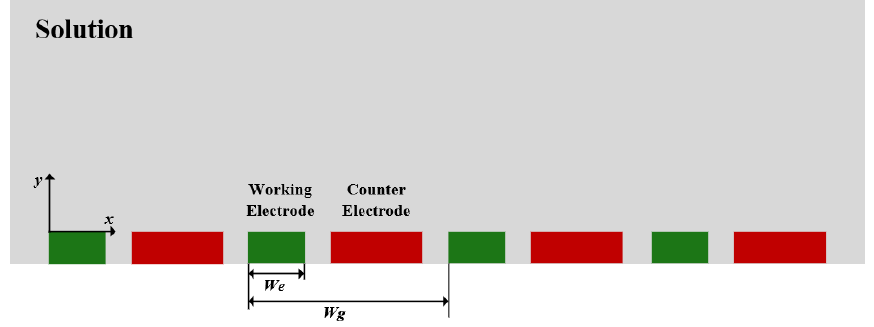
Figure 1. Modeling schematic diagram of UIAE ( We , the width of the working electrode; W g , the spacing between the working electrodes).